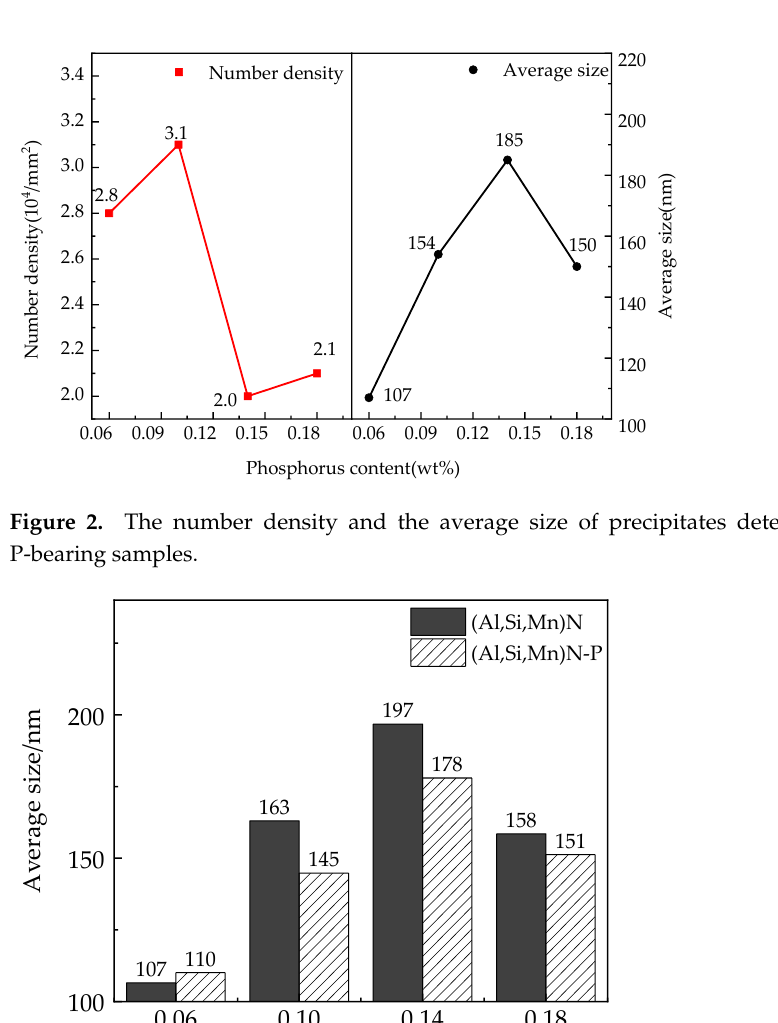
Figure 3. Effect of target P content on the average size of the main precipitates in the finished steel.